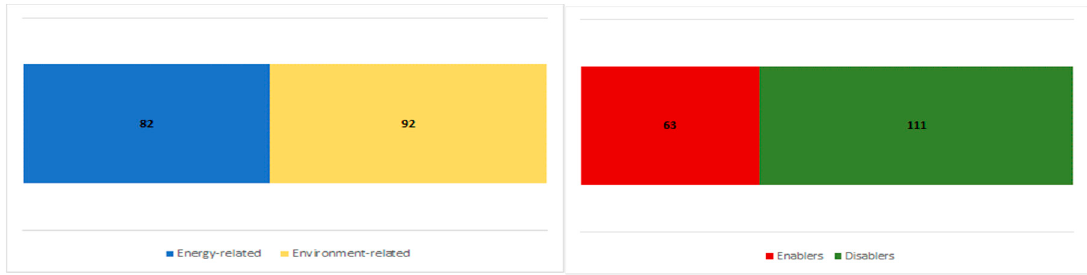
Figure 4. Distribution of themes by category and by type.